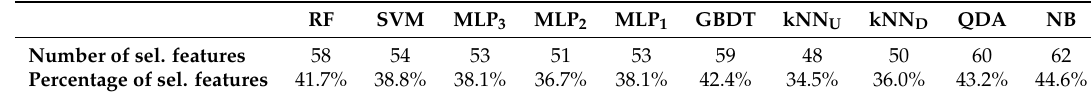
Table 4. Amount of selected features per model.